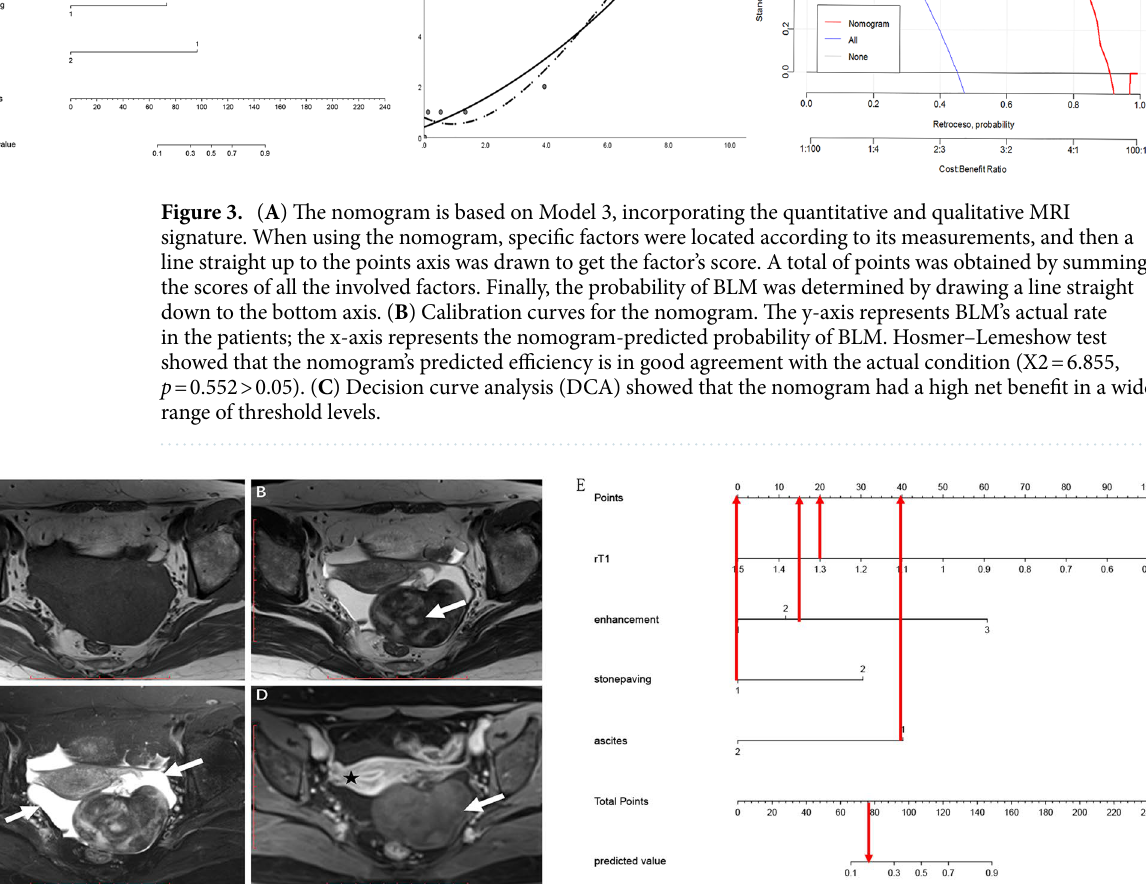
Figure 4. A 65-year-old woman with an OF. ( A ) Axial T1-weighted imaging shows a hypointense tumor in the left ovary. ( B ) On T2-weighted imaging, the tumor exhibits the cystic part (white arrow). ( C ) On the fat- saturated T2WI, the free ascites (white arrow) were seen in the pelvis. ( D ) The tumor showed mild contrast enhancement (white arrow) comparing with the uterus (asterisk). ( E ) This tumor’s total score is 75 (r-T1 = 23, enhancement = 12, stone paving = 0, ascites = 40) with a predicted value of 0.15 calculated by the nomogram, the corresponding probability of OF is